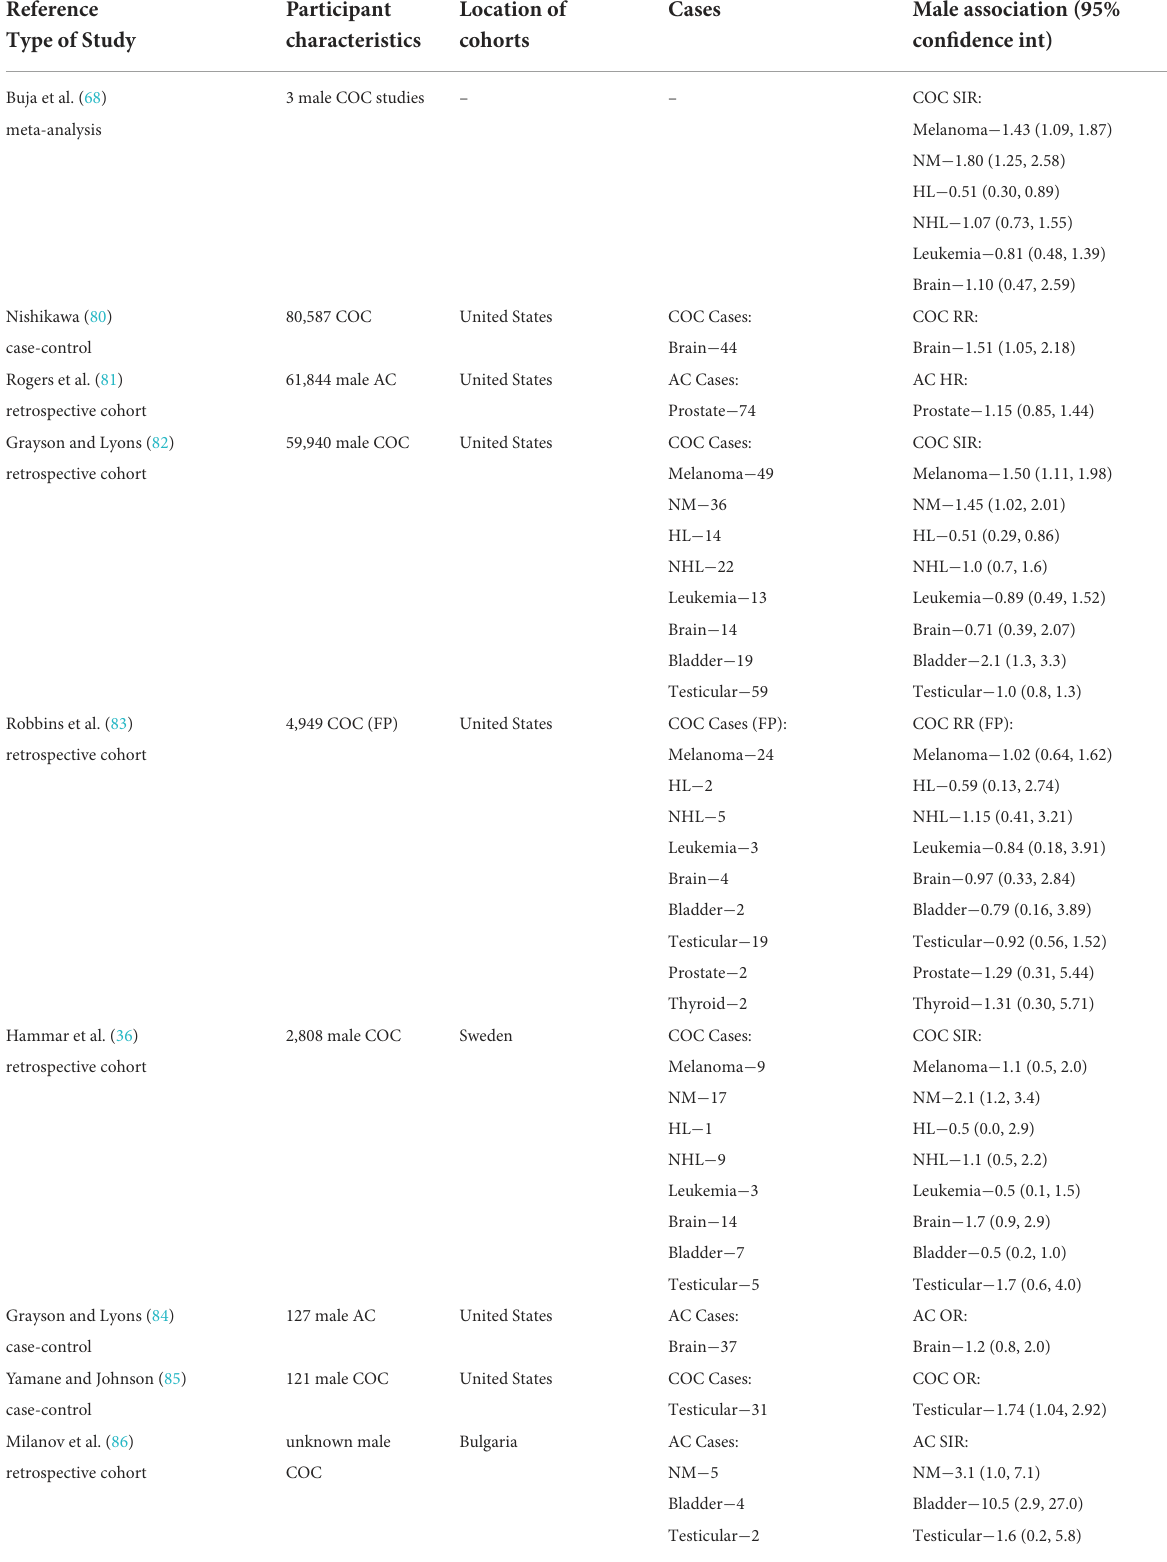
TABLE 2 Cancer outcomes of CIR exposure in military aircrew